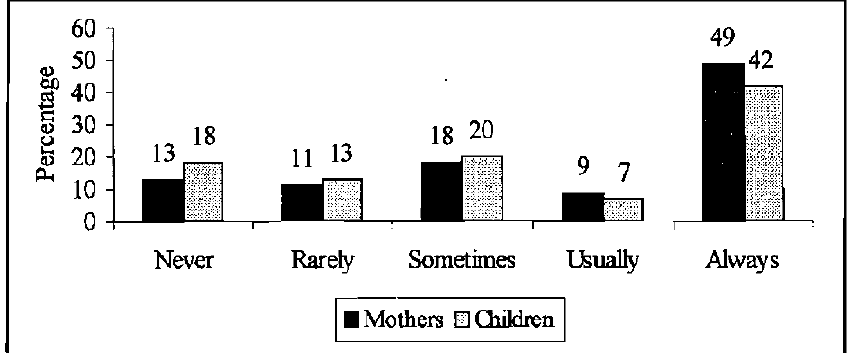
FIGURE 2: Comparison of mothers' and children's use of speech